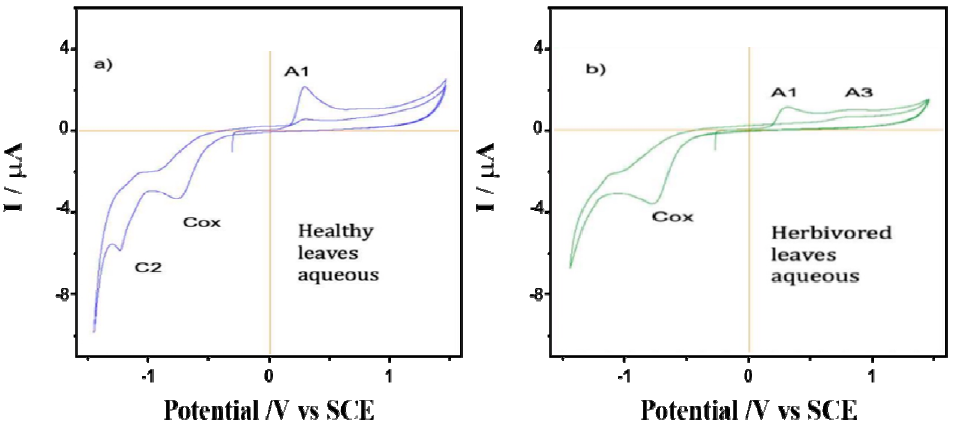
Figure 5. Cyclic voltammograms of films from the water extracts of ( a ) healthy and ( b ) predated leaves of A. cathartica on glassy carbon electrode in contact with air-saturated 0.10 M phosphate buffer at pH 7.0. Potential scan rate 10 mV.s − 1 .